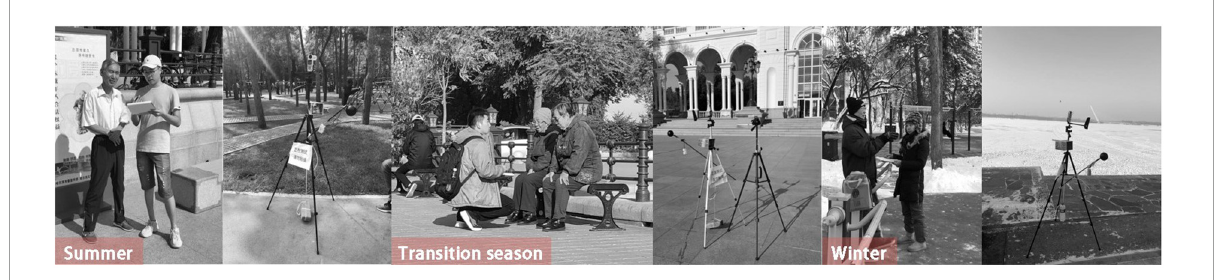
FIGURE2 Questionnaire survey sites and measurement instrument layout in each season.